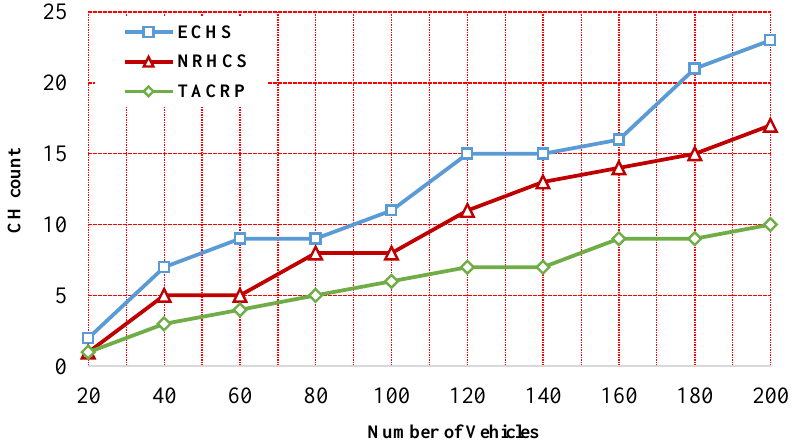
Figure 13. Average Cluster Number Calculation.